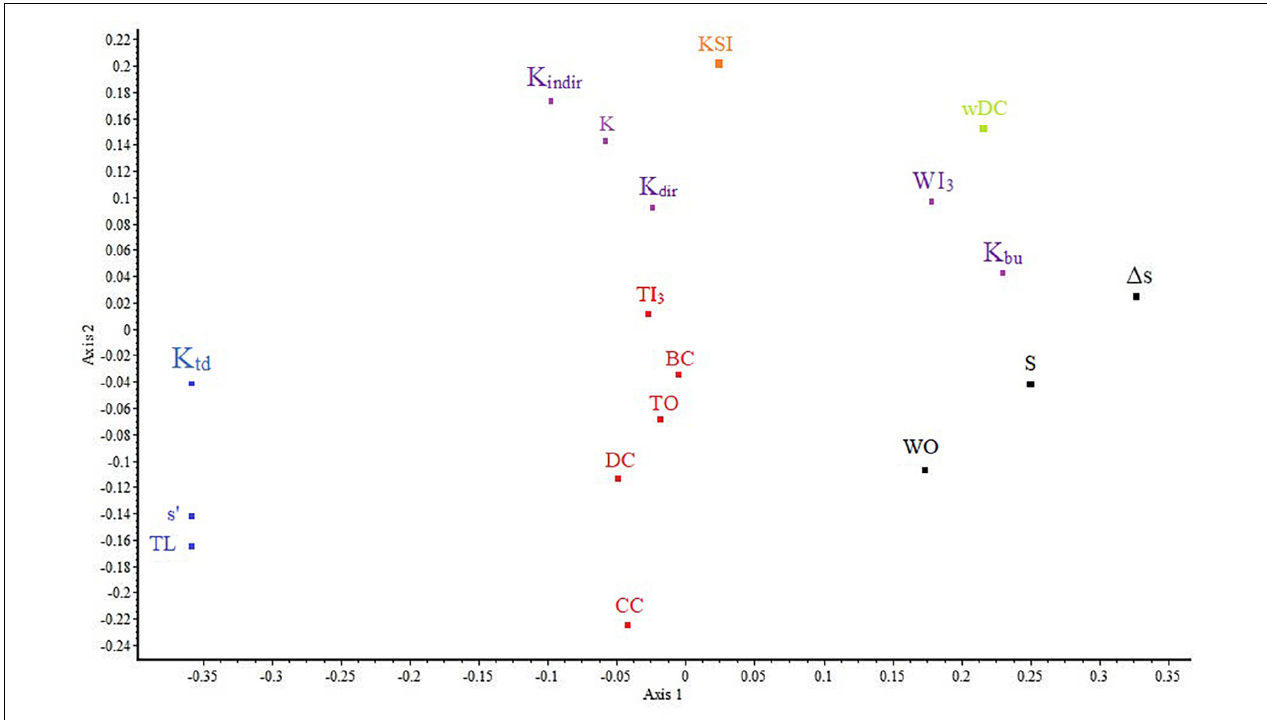
FIGURE 2 | Nonmetric Multidimensional Scaling ordination of the 18 topological indices (stress = 0.08) with the six-group classification of Figure 1 superimposed. Although the ordination is nonmetric, the correspondence between the two results is remarkable, except for the positions of K-related